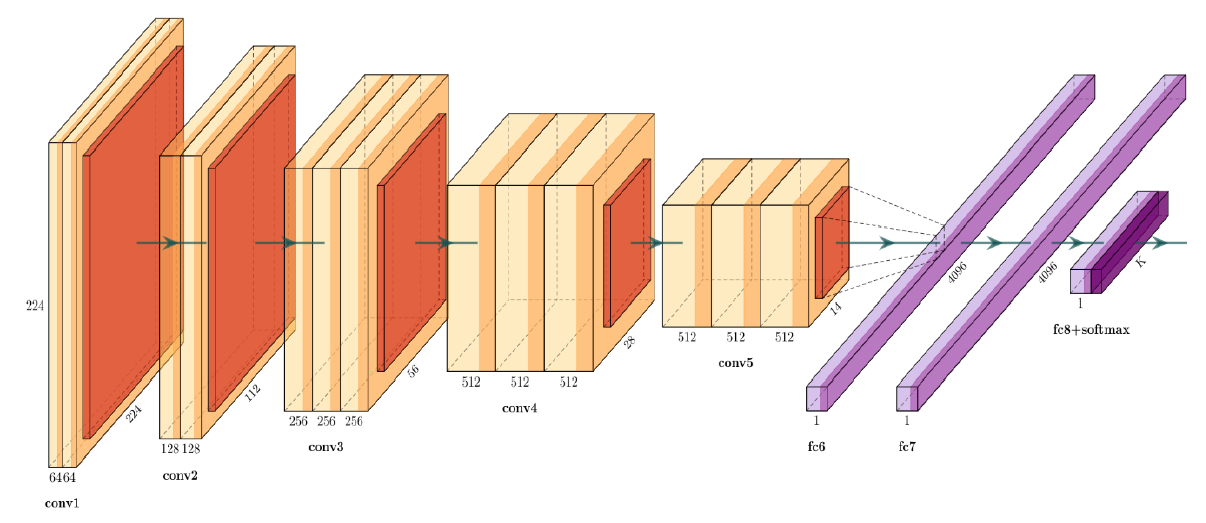
Figure 1 . Network architecture